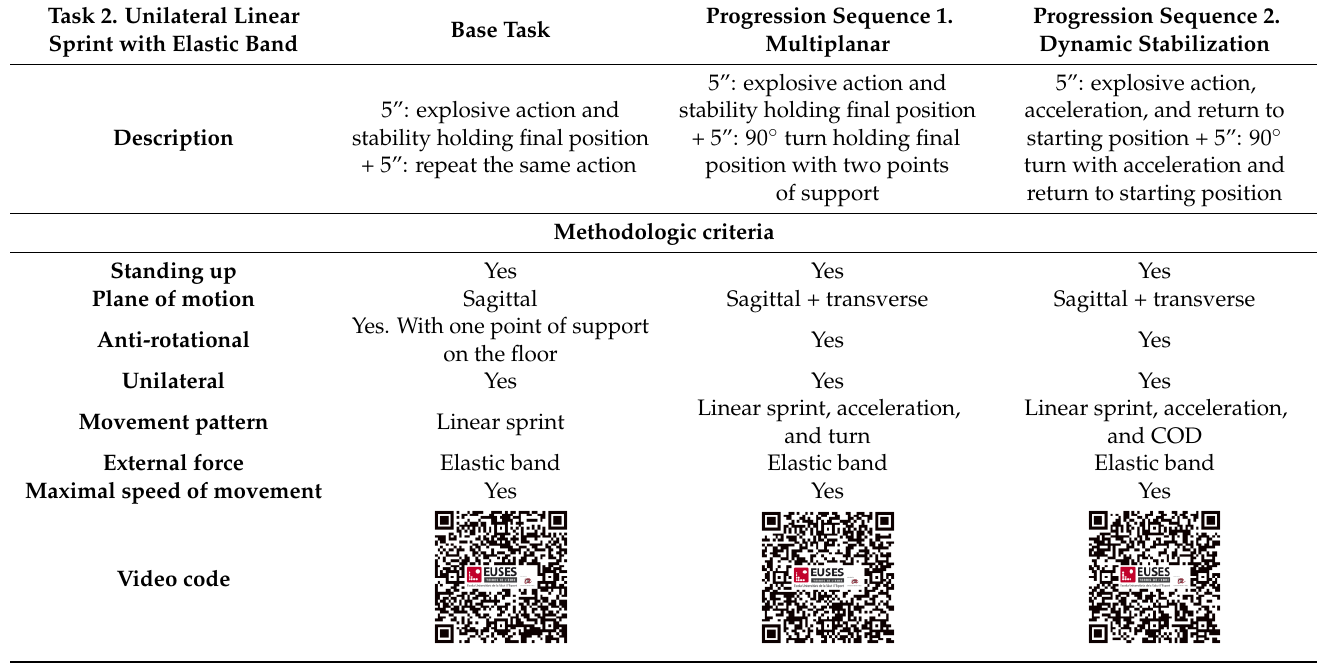
Table 2. Description and methodologic criteria of SCS group’s task 2 and its progressions. Task 2. Unilateral Linear